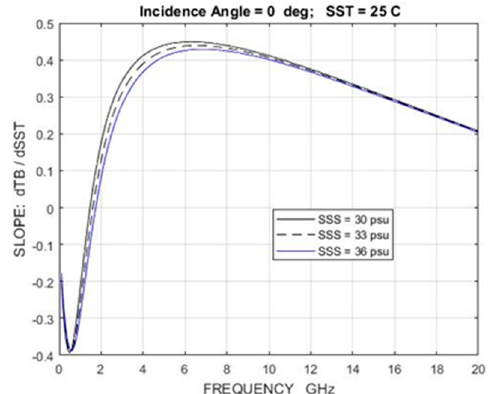
Figure B1. Dependence on salinity of the sensitivity of brightness temperature to changes in temperature, dTB/dSST, for salinity found in the open ocean. This example is for nadir, SST = 25 ℃ and a flat surface (WS = 0 m / s) using the Klein-Swift model function [19]. Top curve: 30 psu; middle curve (dashed): 33 psu; bottom curve: 36 psu.